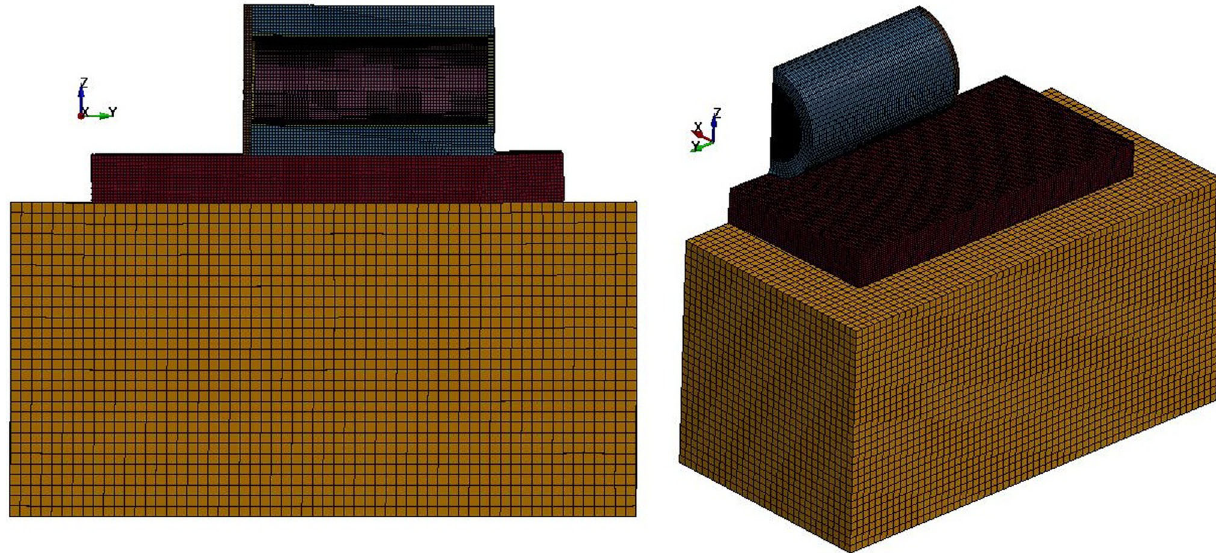
Fig. 16 Impact state in tip-over simulation for 1/3-scale